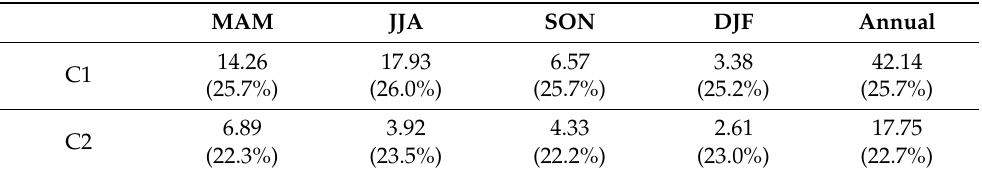
Table 2. The absolute (relative) uncertainties of dust contribution from Central Asia to South (C1) and East Asia (C2) caused by MEE with one deviation based on CALIOP. MAM